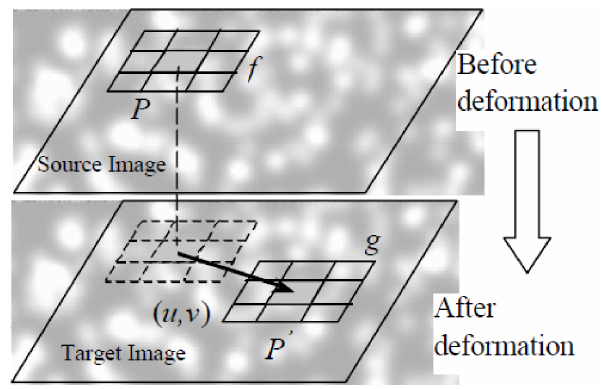
Figure 1. Schematic diagram of the digital speckle correlation method (Ma et al.,